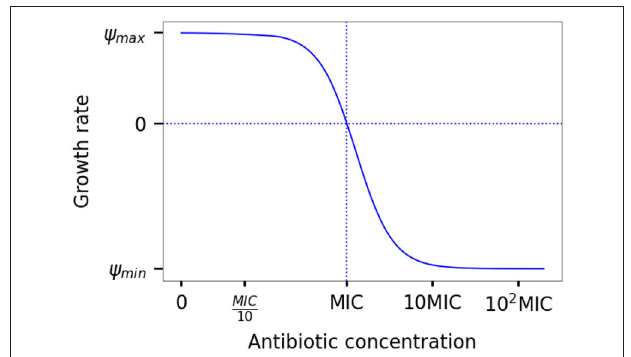
FIGURE 1 | The pharmacodynamic function. The population growth rate 9 depends on the antibiotic concentration A and pharmacodynamic properties, MIC, 9 min , and 9 max